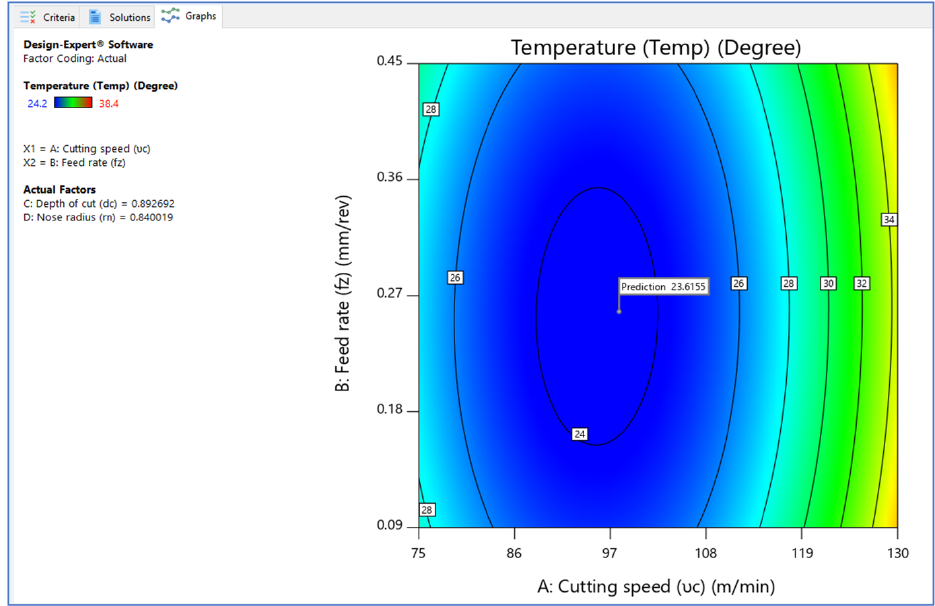
Figure 6. Contour plot on desirability (V c vs. F z ).